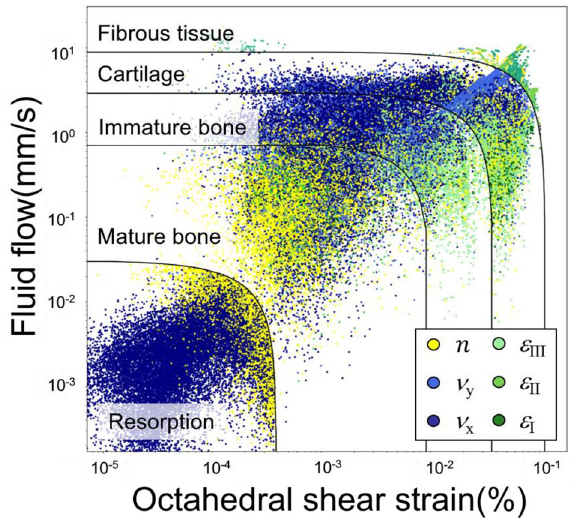
Figure 7. The phase diagram of tissue transition regions (from fibrous tissue to resorption) with logarithmic axes of fluid flow and octahedral shear strain. The color of each point indicates the most important physical property among the six to the corresponding tissue region provided by